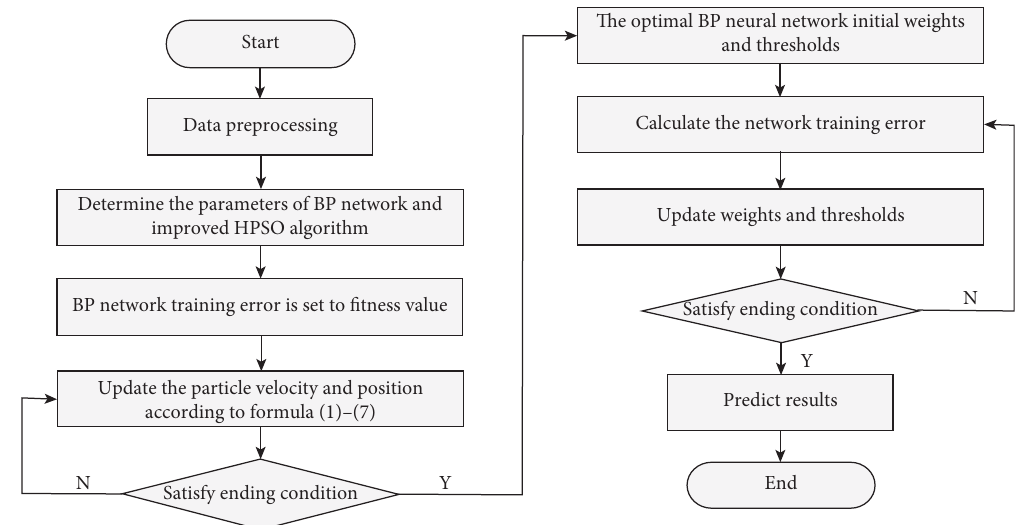
Figure 2: Flow of improved HPSO-BP algorithm.